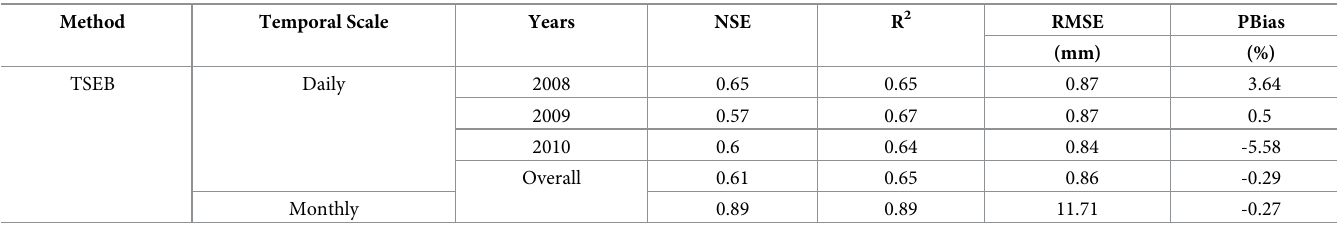
Table 2. The general performance results of simulated daily evapotranspiration from 2008 to 2010. Method